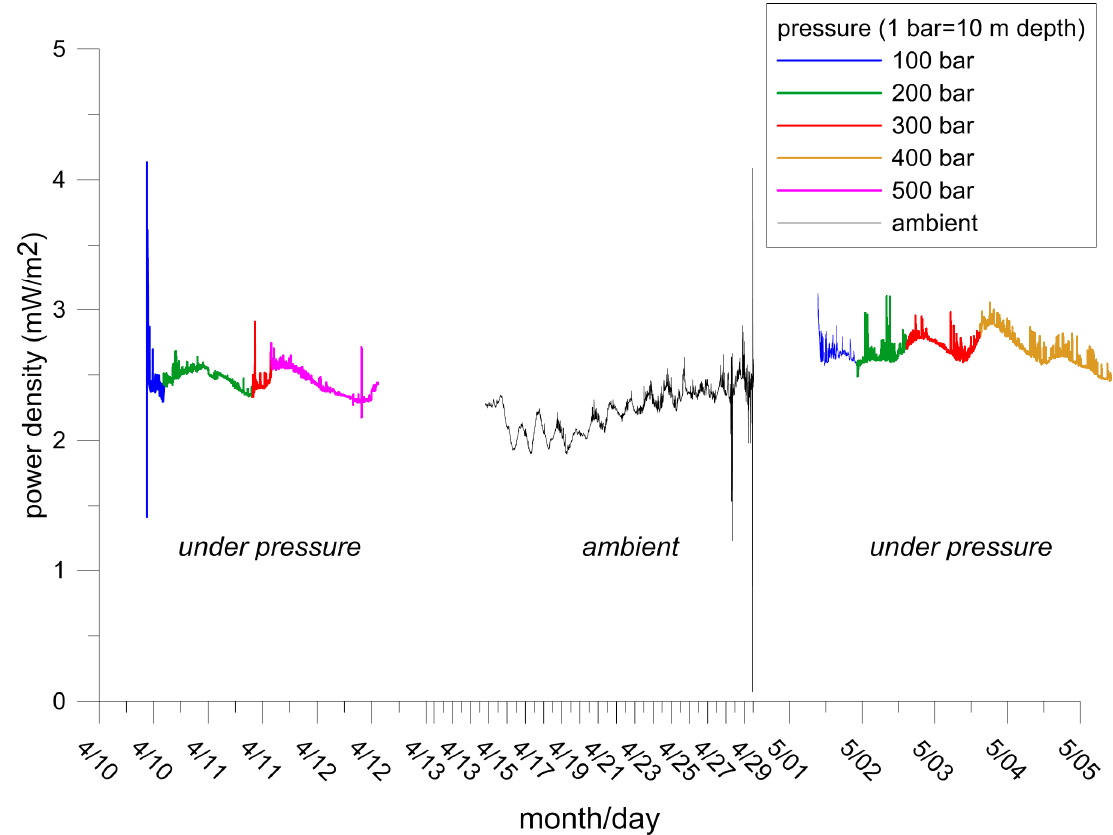
Figure 14. Effects of pressure on MFC output in the laboratory from sediment collected at 1000 m.